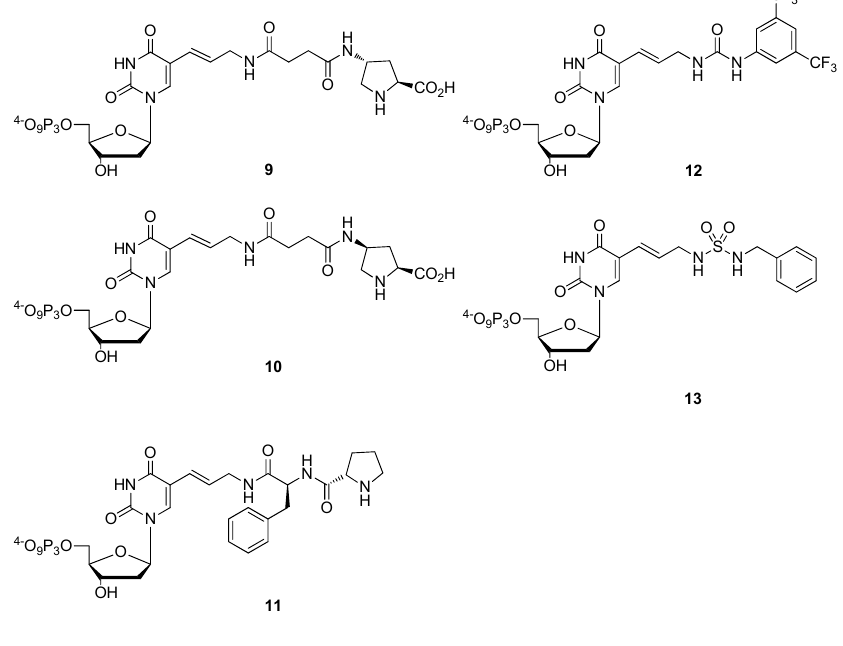
Figure 1. Chemical structures of the proline-containing analogues dU t P TP ( 9 ); dU c P TP ( 10 ); and dU FP TP ( 11 ); the urea modified dU Bpu TP ( 12 ); and the sulfonamide functionalized dU Bs TP ( 13 ) [51].